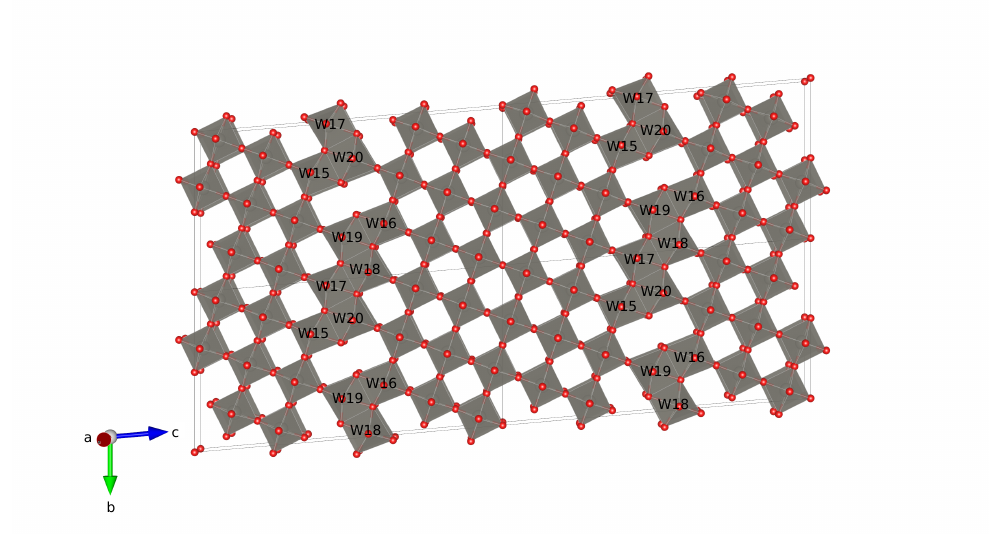
Figure 2. Crystal structure of the W 20 O 58 supercell. Tungsten atoms located along the zigzag stripes are